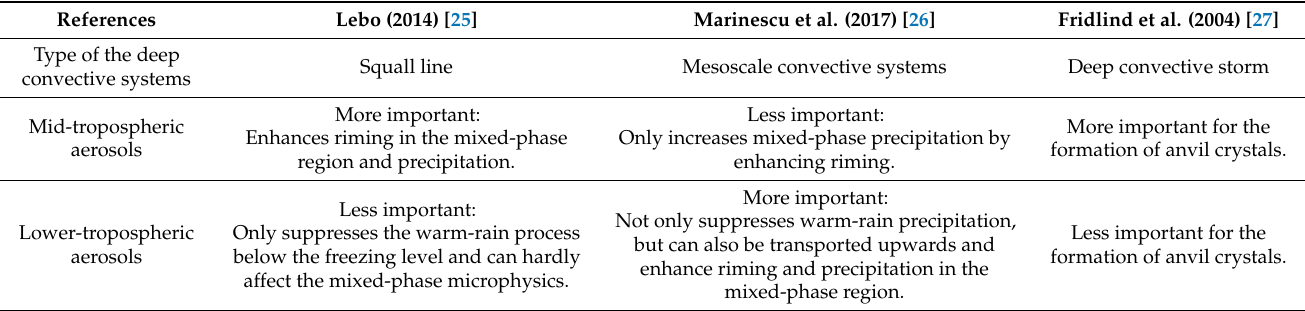
Table 1. The relative importance of cloud condensation nuclei (CCN) aerosols from different heights on deep convective systems in previous